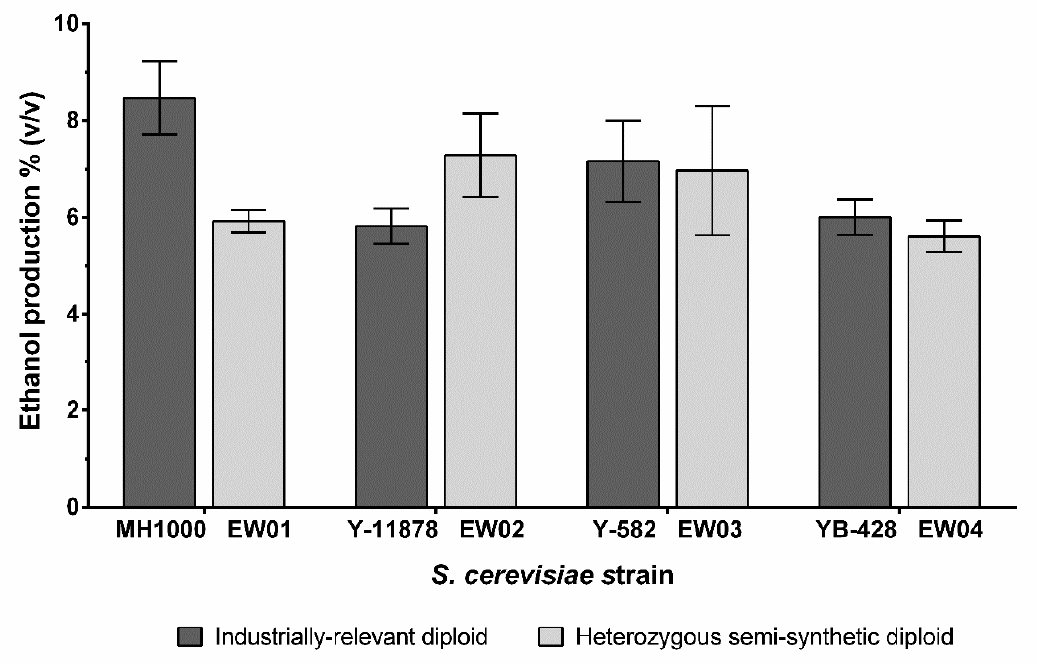
Figure 4. Ethanol production of S. cerevisiae industrially relevant diploids (MH1000, Y-11878, Y-582 and YB-428) and semi-synthetic heterozygous diploids (EW01-EW04). Ethanol concentration was measured after cultivation in YPD with high glucose concentration (20 g L –l glucose) at 30 °C for 120 h. There was no difference in ethanol production from semi-synthetic strains compared to the corresponding industrial diploids, except for the EW01 strain, compared to the parental MH1000 strain.